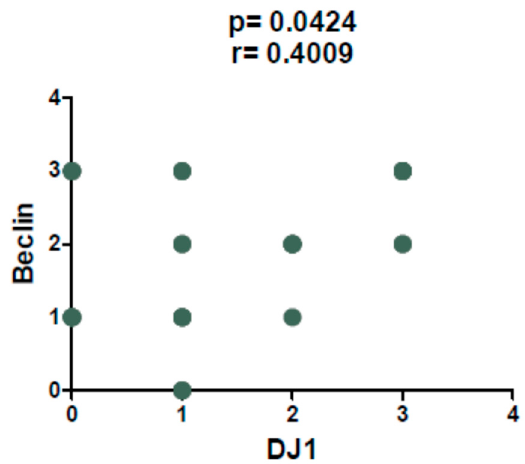
Figure 2. Spearman’s test revealed a direct correlation between DJ-1 and Beclin immunoscore ( p = 0.0424, r = 0.4009).